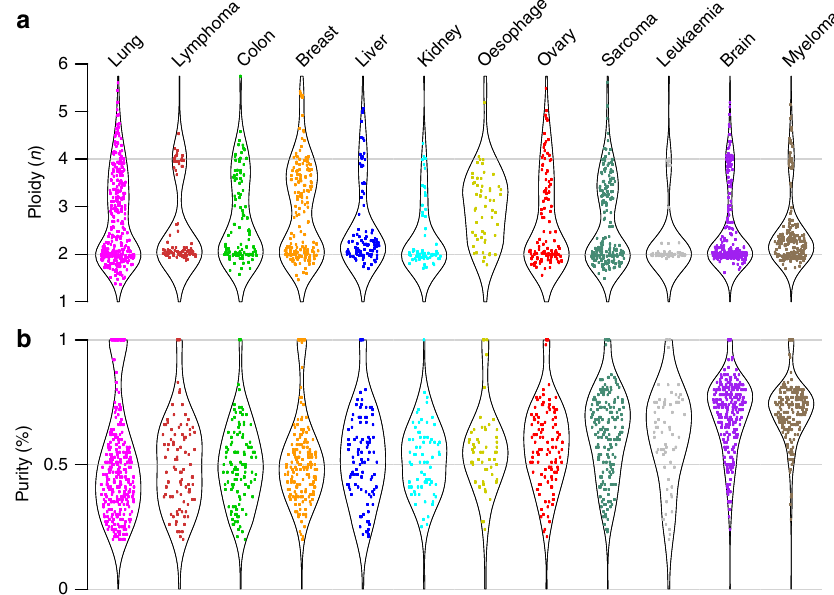
Fig. 1 Tumour ploidy and purity across cancer types. A total of 2218 cancer samples hybridised to Affymetrix 250K StyI arrays, encompassing cancers arising in 12 broadly de fi ned tissue types, were subjected to ASCAT analysis. ASCAT estimates of a tumour ploidy and b tumour purity are shown. Samples that failed ASCAT analysis (81; 3.6%) and samples that showed little to no copy number aberrations (273; 12.8%) and therefore have less accurate purity estimates are not included in these